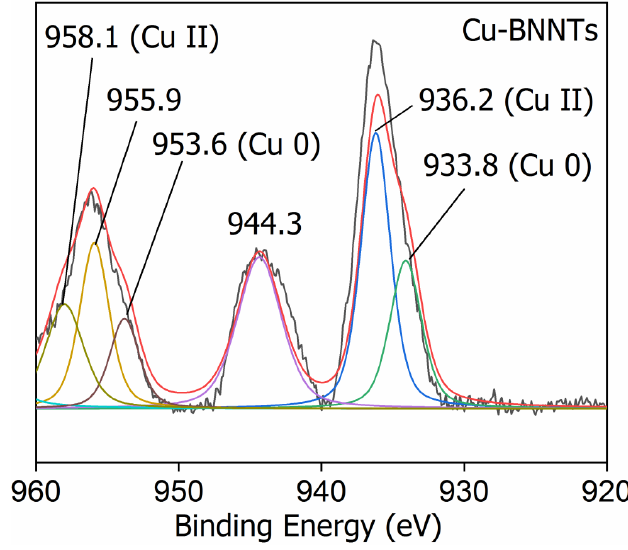
Figure 6. High-resolution spectrum XPS for Cu-BNNTs.